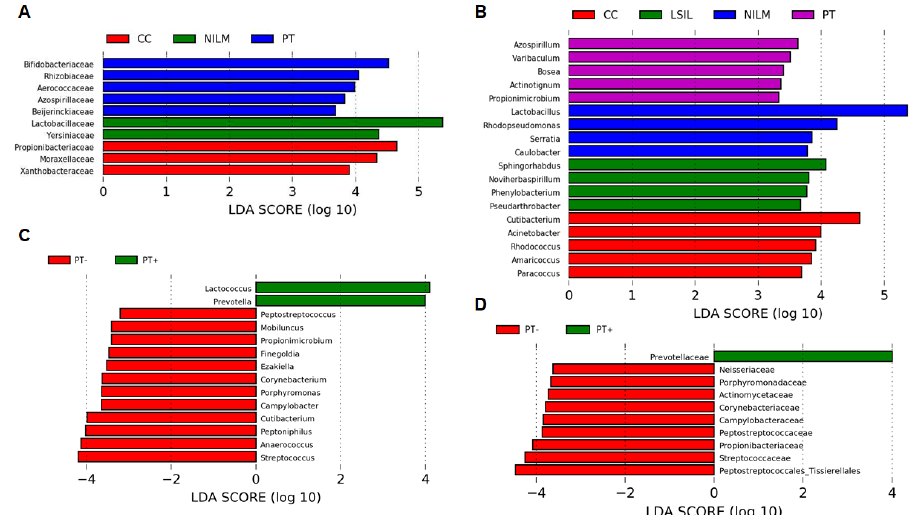
Figure 6. Histograms of linear discriminant analysis (LDA) scores computed for features differentially abundant among patient groups at the family and genus levels according to diagnosis ( A , B ) and treatment type ( C , D ). The LDA score on the log 10 scale is indicated at the bottom. The greater the LDA score, the more significant the phylotype biomarker is in the comparison.